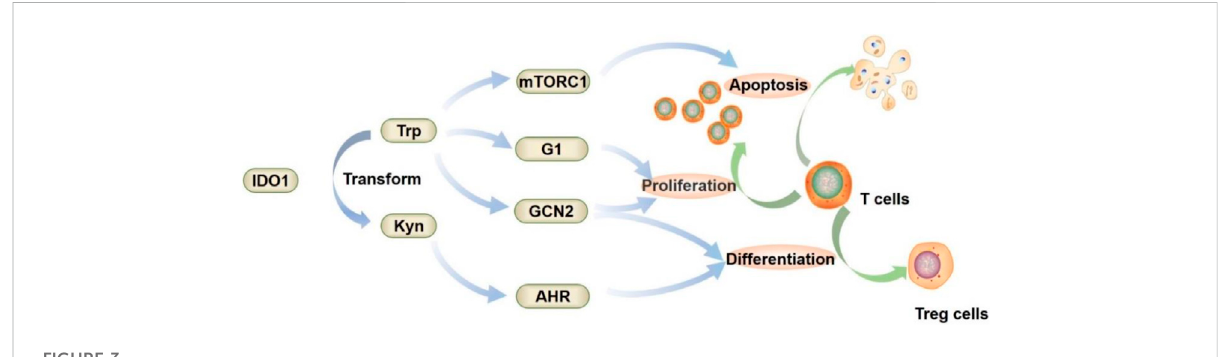
FIGURE 3 Mechanism of IDO1-mediated tumor immune